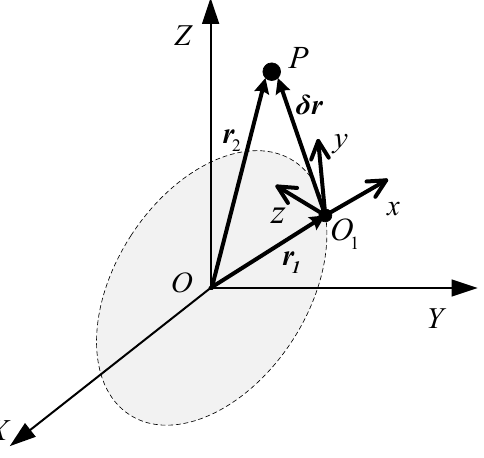
Figure 1. Pursuer and reference satellite.